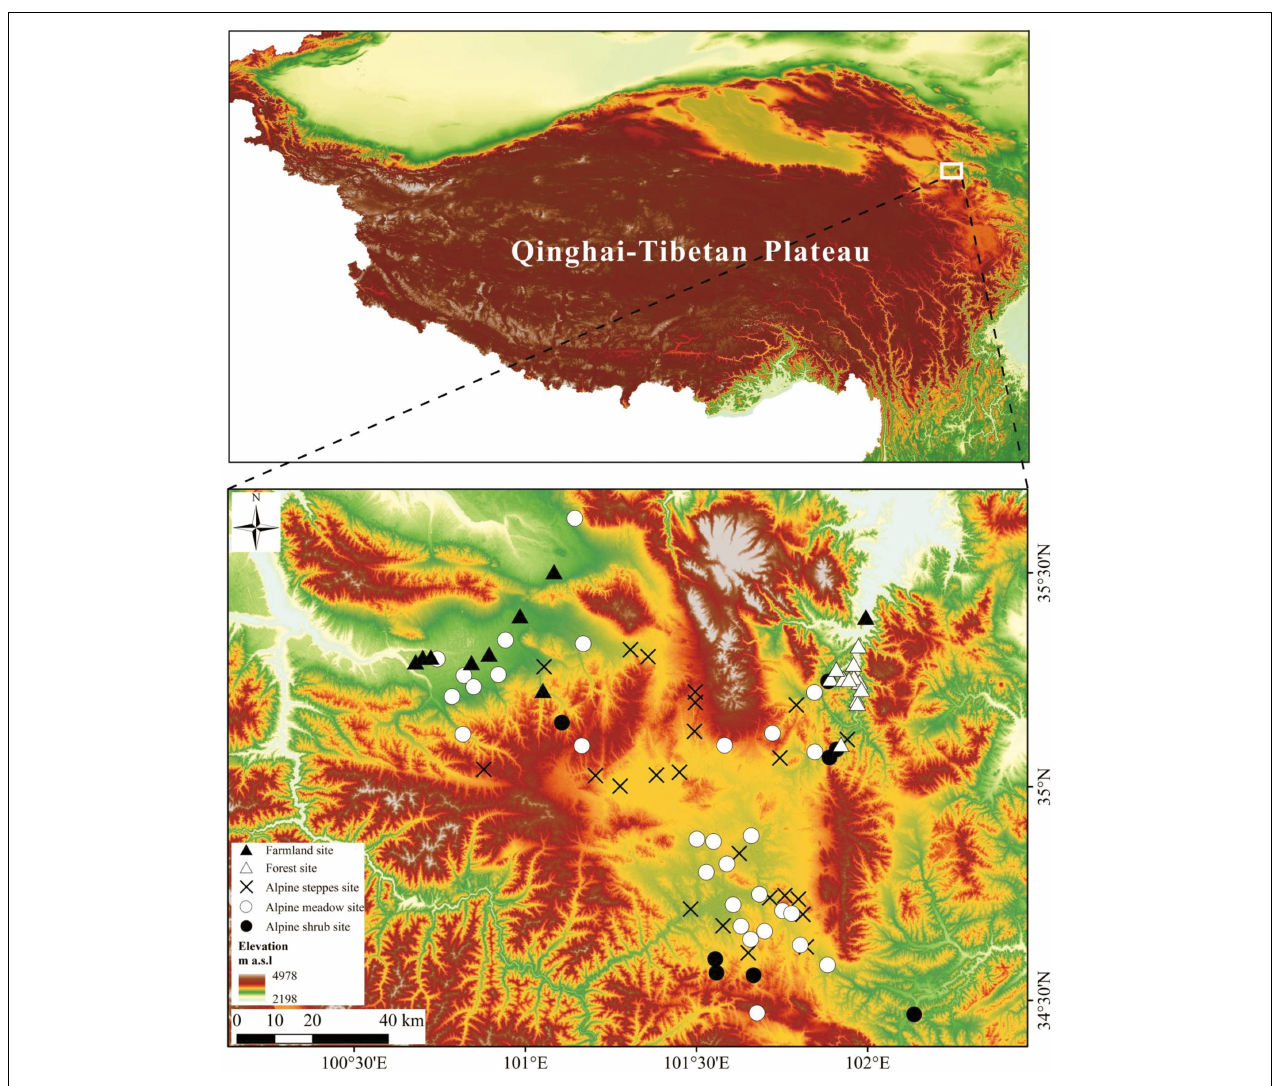
FIGURE 1 | Location map of sampling sites in eastern Qinghai-Tibetan